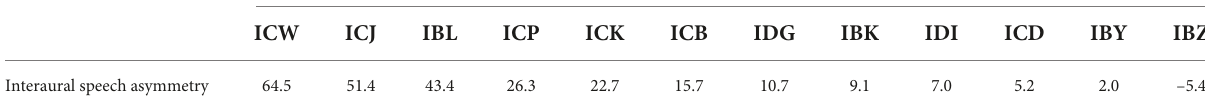
TABLE 2 Interaural speech asymmetry for each participant, defined as the difference in RAU scores between the Better Ear and Poorer Ear